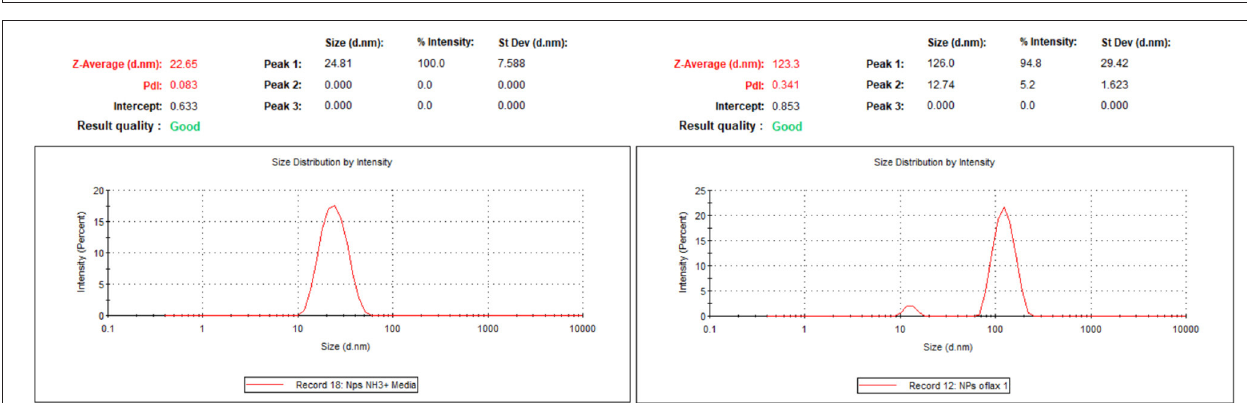
FIGURE 8 | DLS measurements for SNPs-NH 2 and SNPs-Ofloxacin on the right both in PBS at pH 7.4.